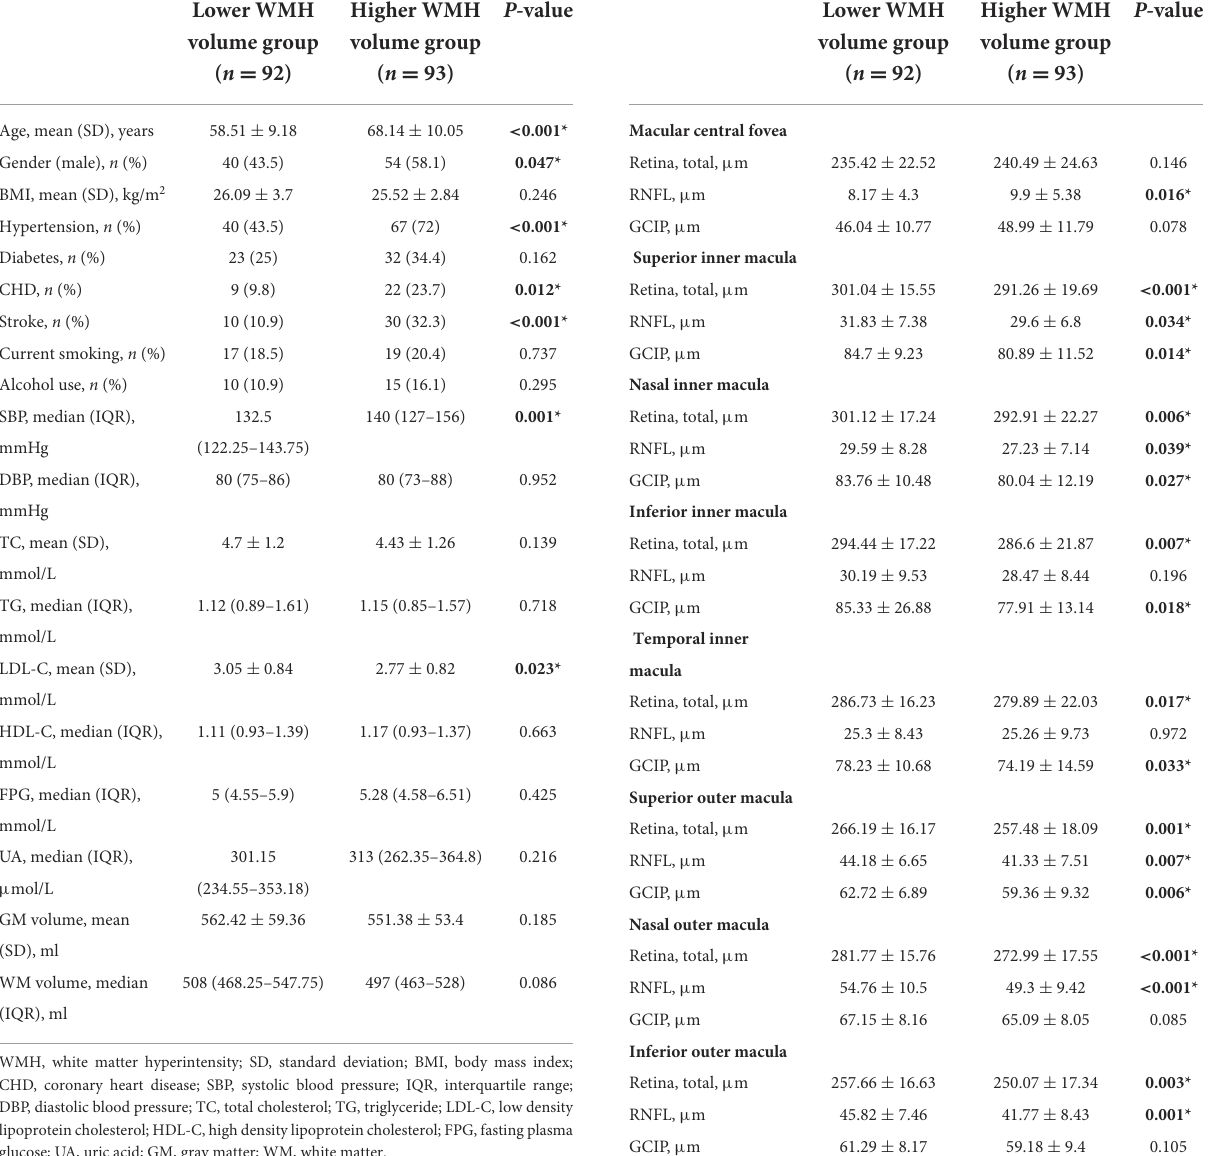
TABLE 1 Comparison of baseline characteristics between the lower white matter hyperintensity volume group and the higher white matter hyperintensity volume group.